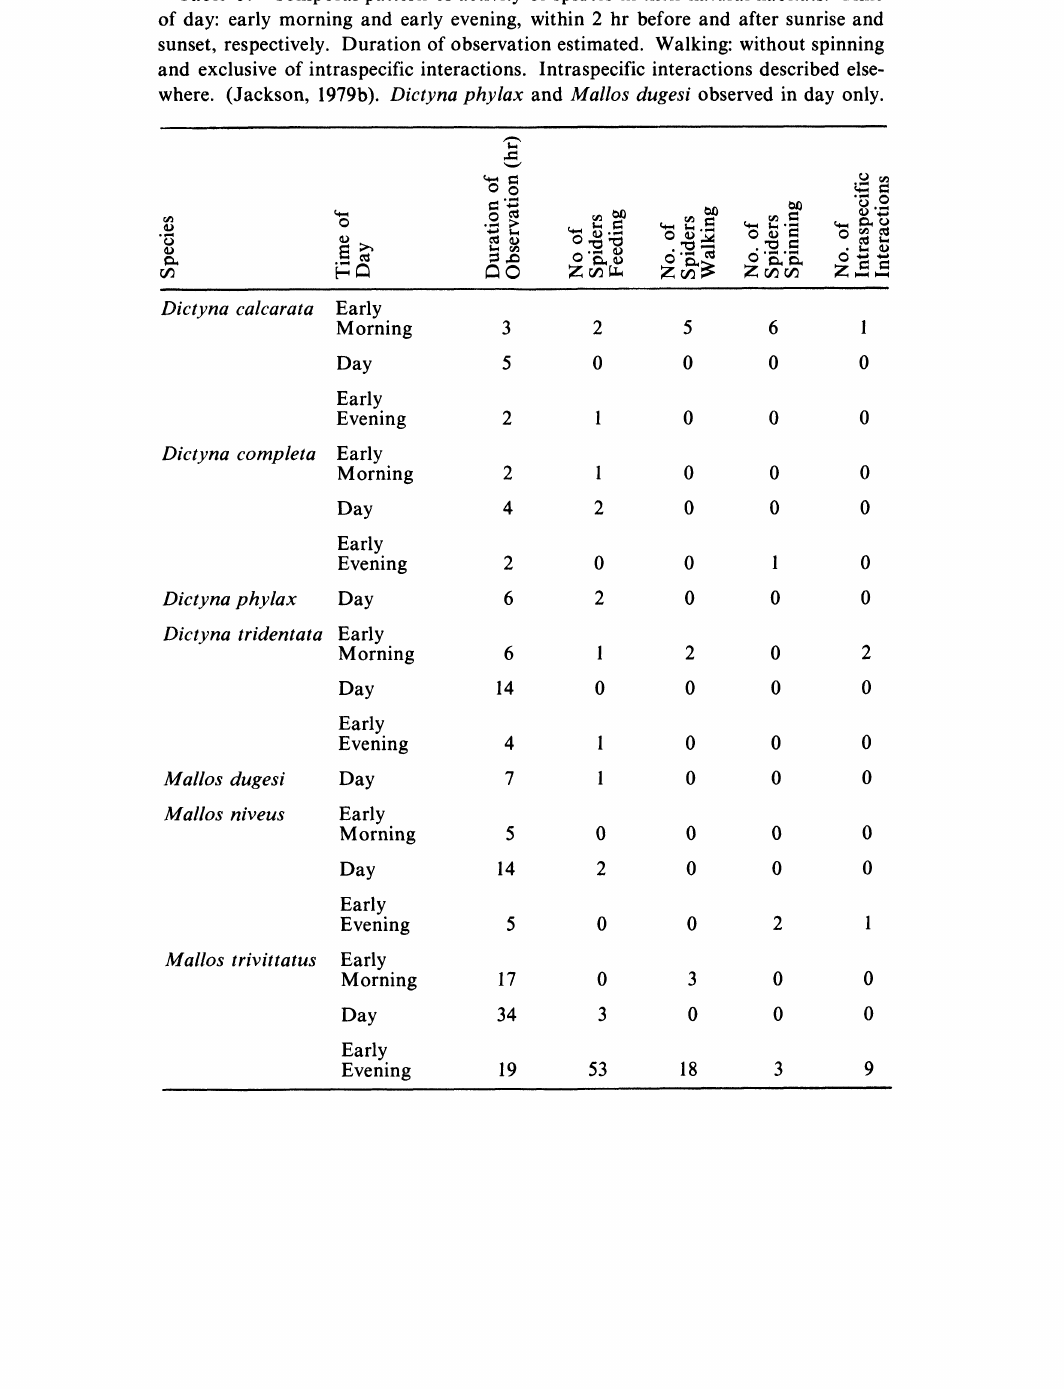
Table 3. Temporal pattern of activity of spiders in their natural habitats. Time of day: early morning and early evening, within 2 hr before and after sunrise and sunset, respectively. Duration of observation estimated. Walking: without spinning and exclusive of intraspecific interactions. Intraspecific interactions described else- where. (Jackson, 1979b). Dictyna phylax and Mallos dugesi observed in day only.